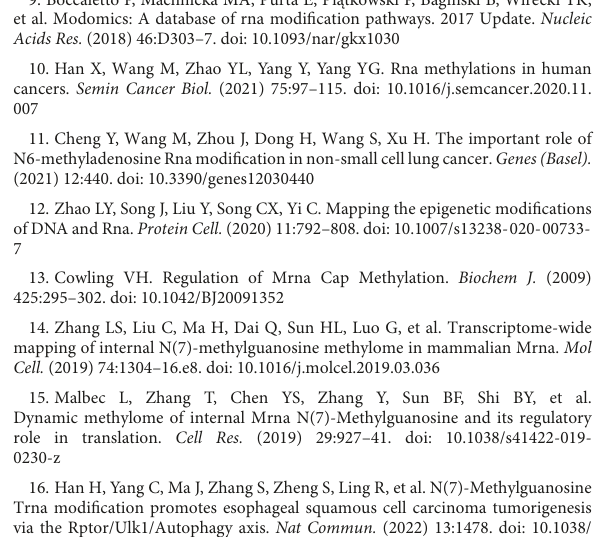
SUPPLEMENTARYTABLE1 Three m 7 G-related gene sets. SUPPLEMENTARYTABLE2 201 prognostic genes through univariate Cox